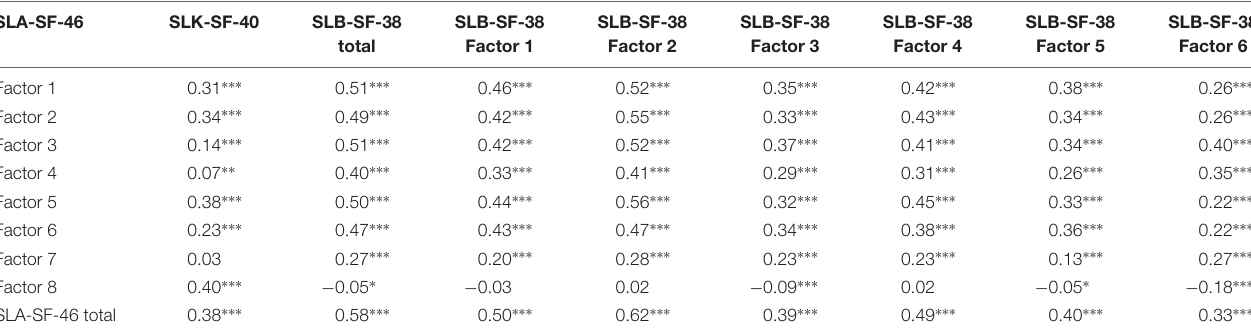
TABLE 9 | Correlations between SLA-SF-46 and other service leadership scales and subscales.